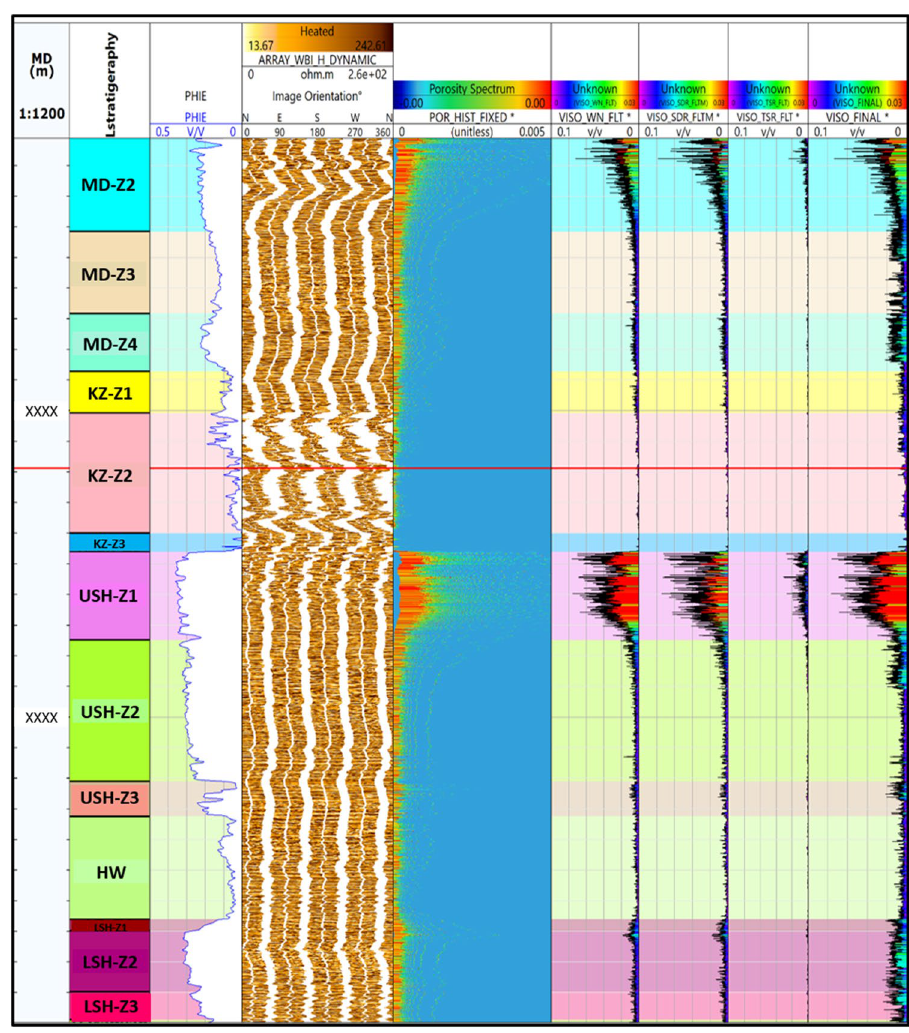
Fig. 1 Porosity Spectrum in well #2. Track 5: Porosity spectrum, Track 6: vug porosity by WN method, Track 7: Vug porosity by SDR method, Track 8: Vug porosity by TSR method, Track 9: Final vug